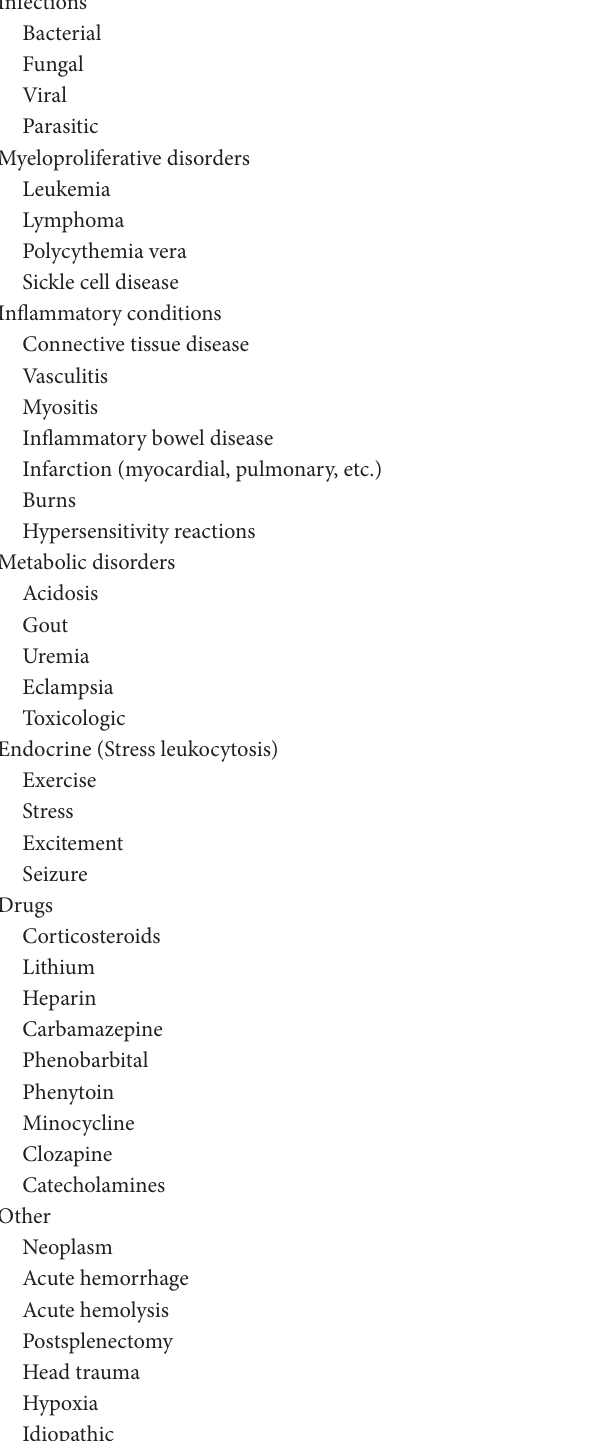
Table 1: Causes of